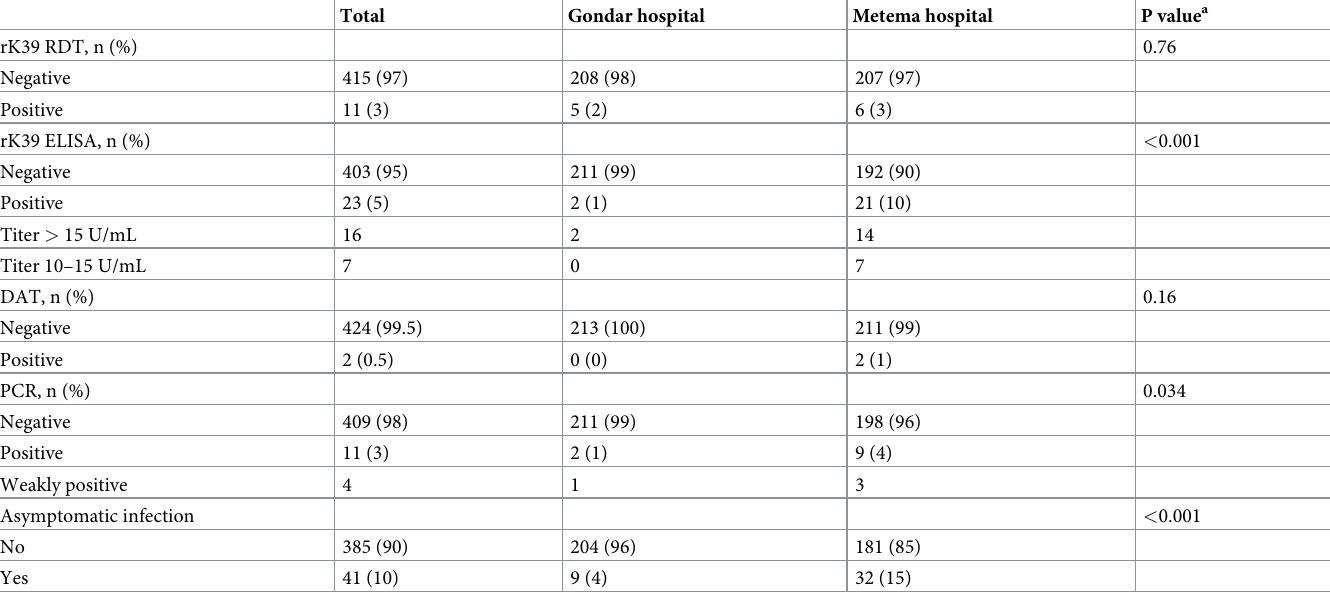
Table 2. Prevalence of asymptomatic Leishmania infection of blood donors at two sites in Northwest Ethiopia, 2020.